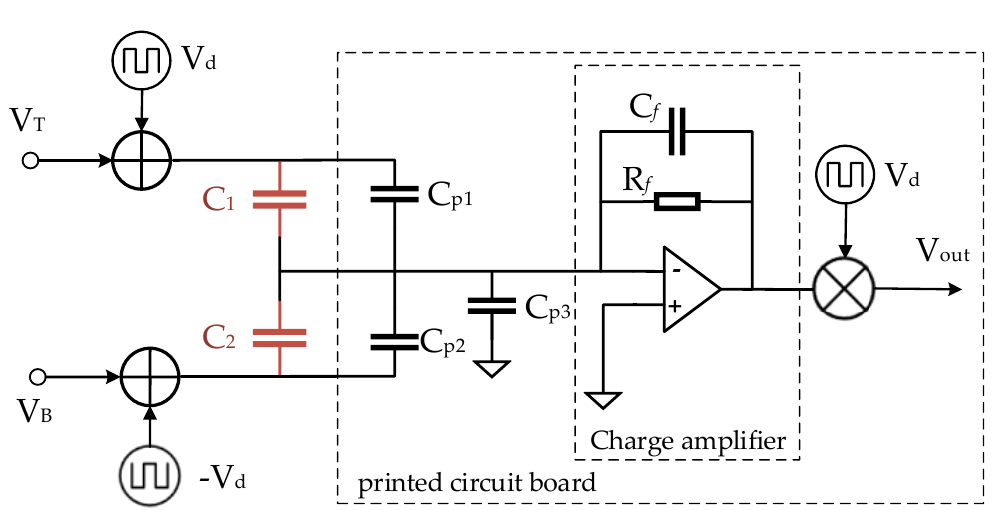
Figure 3. The electrical model of the measurement circuit.